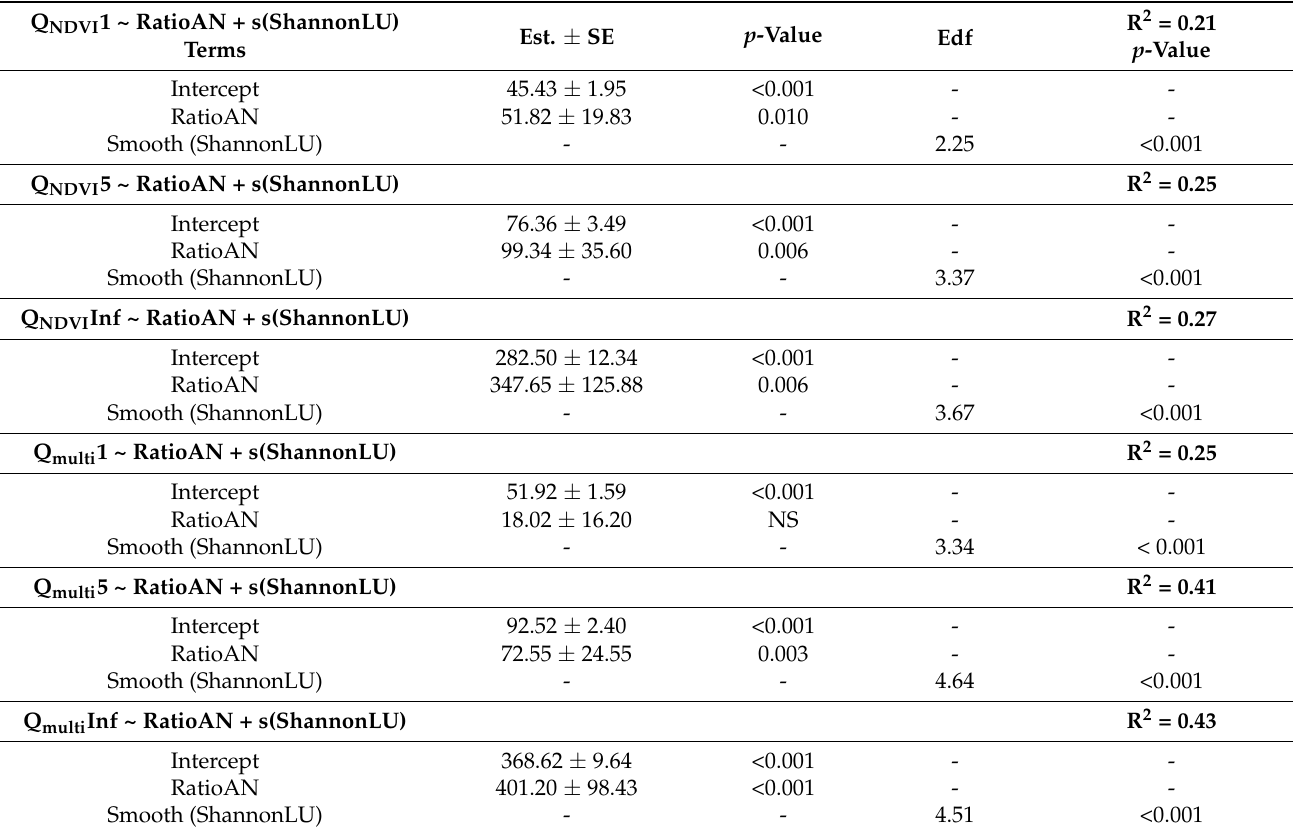
Table 1. Summary of generalized additive models (GAMs) for spectral heterogeneity (Rao’s Q index calculated from NDVI timeseries (Q NDVI ) and from a multispectral image (Q multi ) with three different weights for the distance matrix (i.e., 1, 5, infinite) vs. alien native species richness ratio (RatioAN, linear term) and Shannon index calculated on land uses (ShannonLU, smooth term). Est. ± SE = estimate ± standard error; Edf = effective degrees of